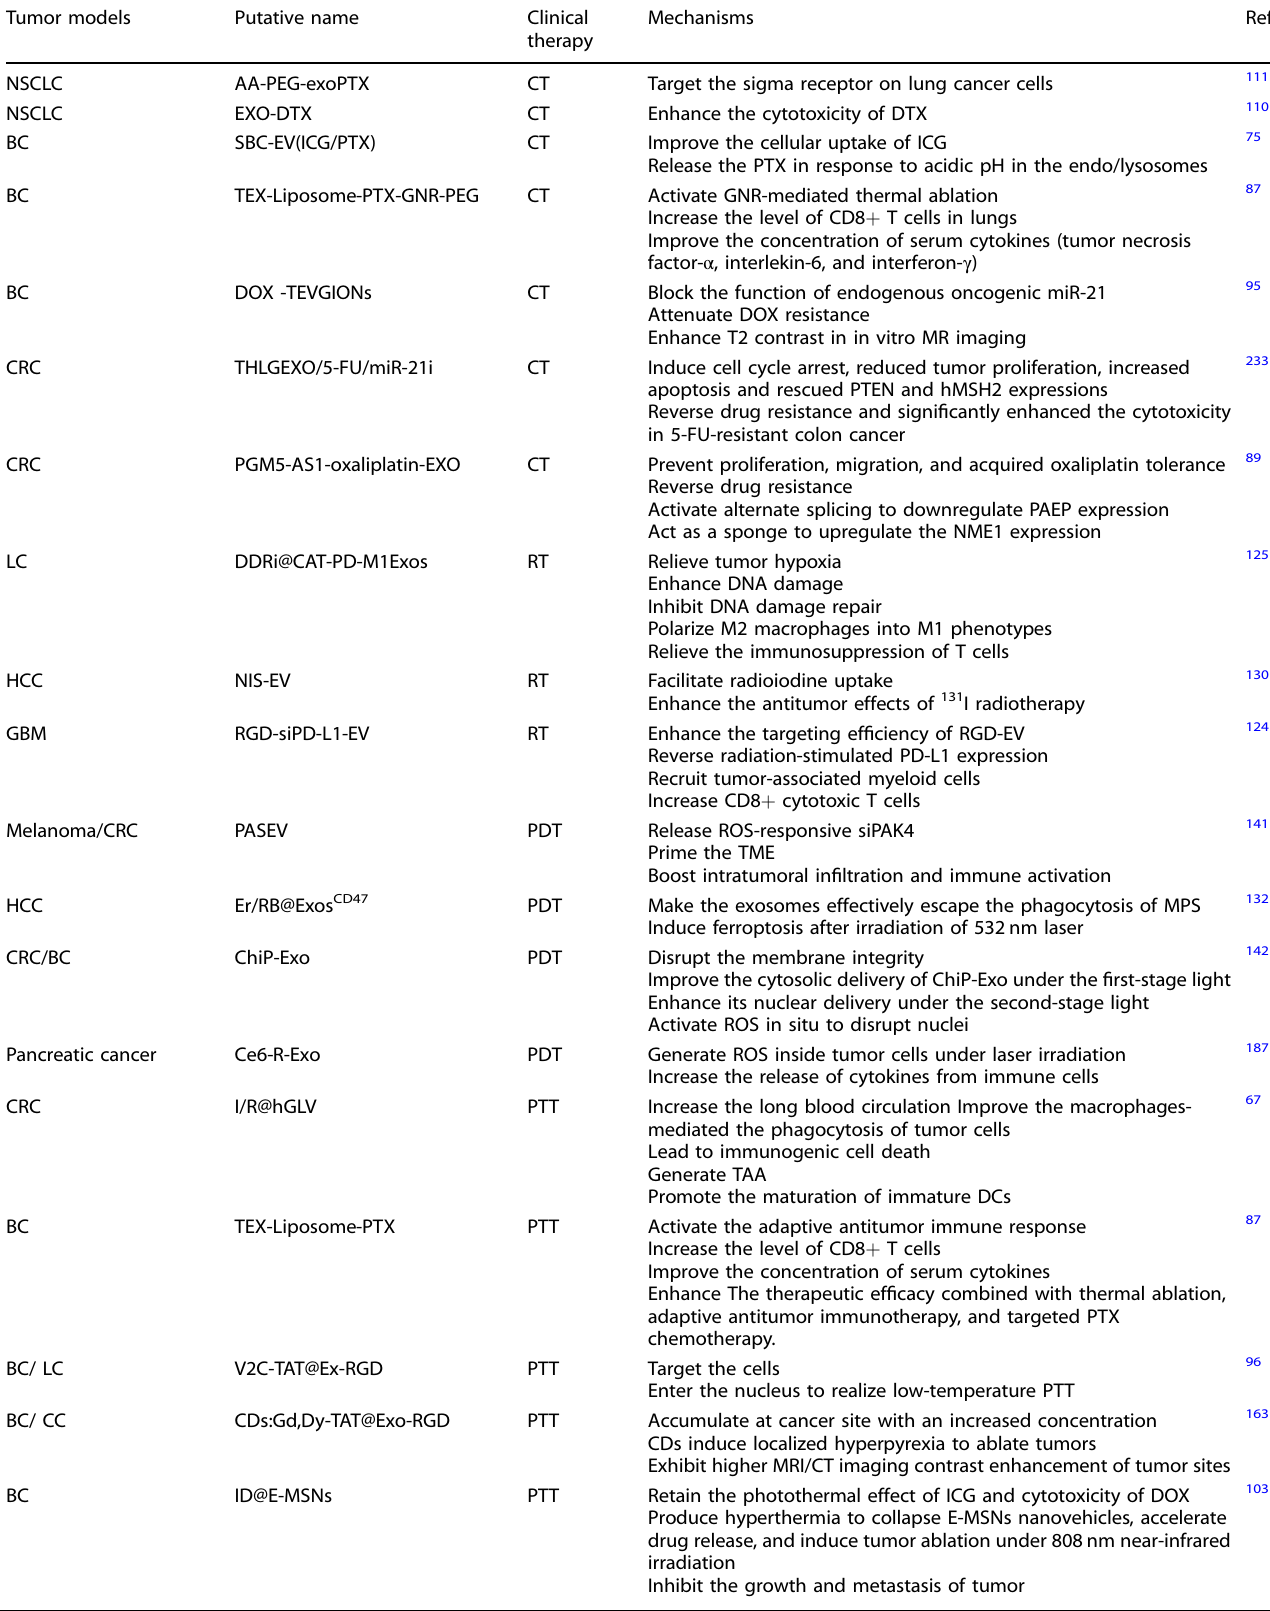
Table 2. The preclinical trials of engineered exosomes Tumor